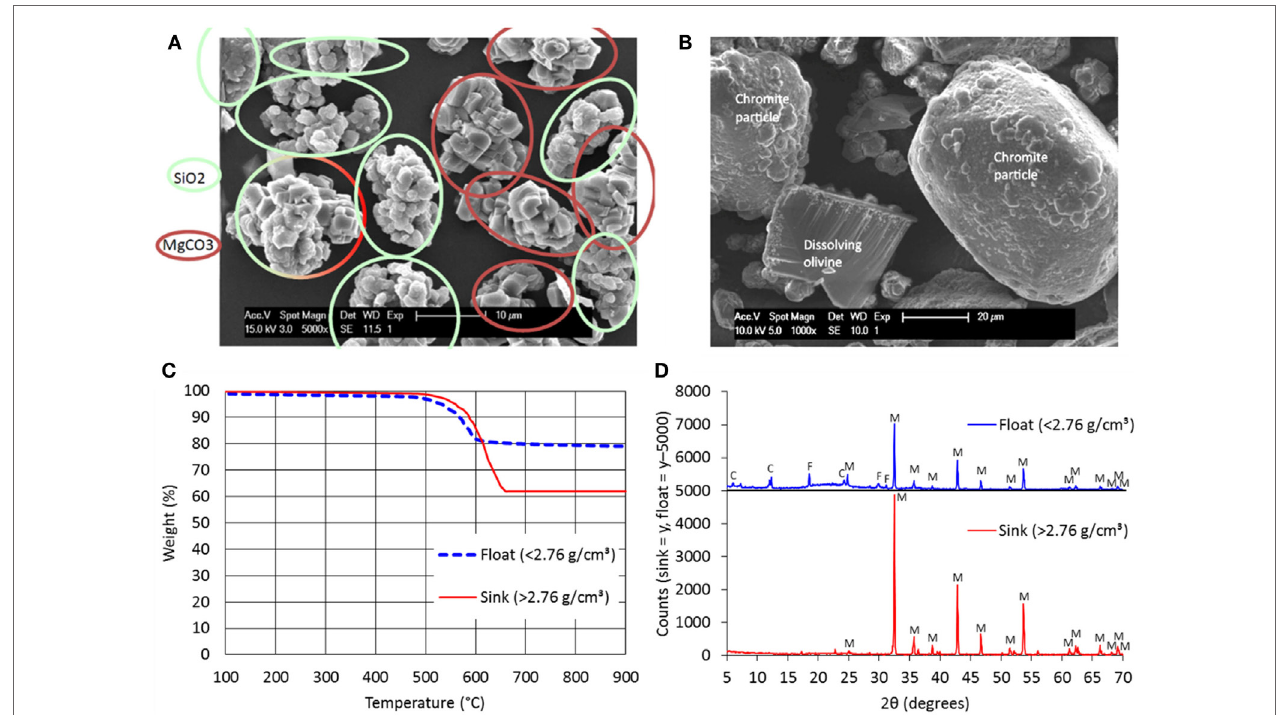
FiGUre 2 | (A) SEM–EDX characterization of reaction products (carbonate- and silica-rich particles indicated); (B) SEM–EDX characterization of reaction products (residual olivine and chromite-rich particles indicated); (c) TGA analysis of dense liquid-separated reaction products; (D) XRD analysis of dense liquid-separated reaction products (C, clinochlore; F, forsterite; M,